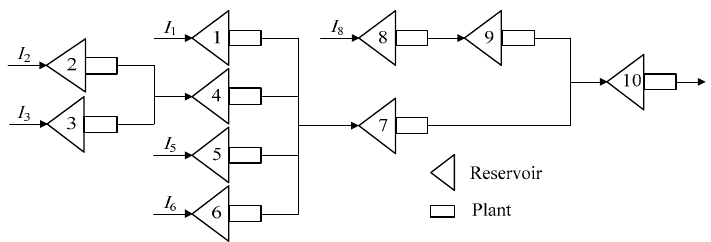
Table 5. The computational parameters of the mature multi-reservoir system.